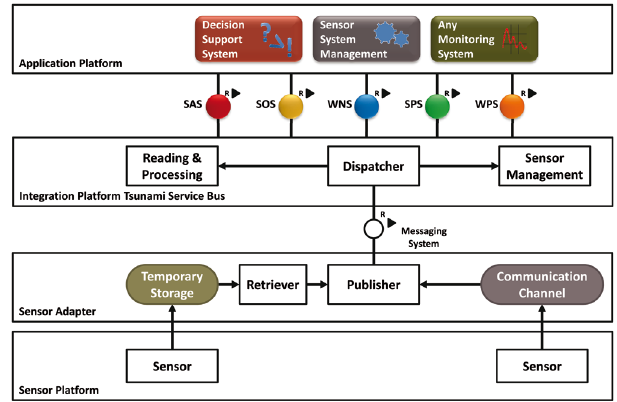
Fig. 4. High level sensor system integration by Integration Platform